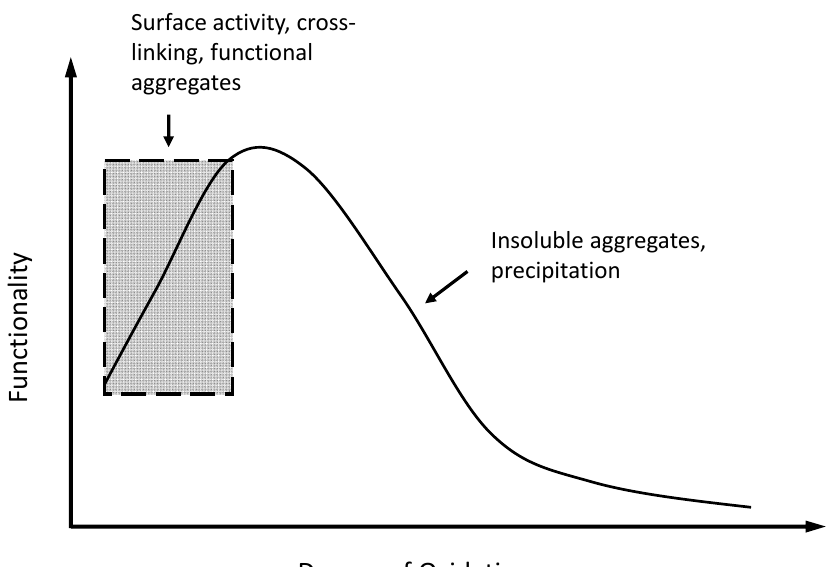
Figure 2. Functionality of oxidatively modified proteins. Functionality: gelation, emulsification, foaming, film formation, water-holding, etc.